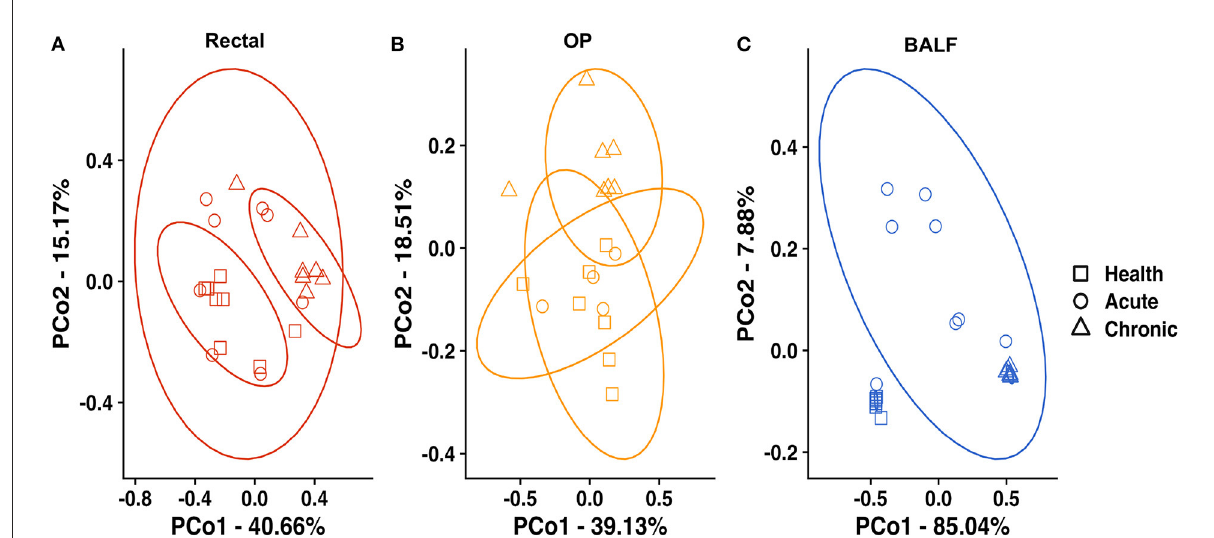
FIGURE3 Principal coordinate analysis at each site—of Bray Curtis similarity index in rectal samples (A) , OP swabs (B) and BALF (C) in healthy cats at baseline (squares), acute asthma (6 weeks) (circles) and chronic asthma (36 weeks) (triangles). PERMANOVA showed a significant difference in community composition at all sites between health and chronic asthma, as well as health and acute asthma in the lower airways. Ellipses represent 95% confidence interval. OP, oropharyngeal; BALF, bronchoalveolar lavage